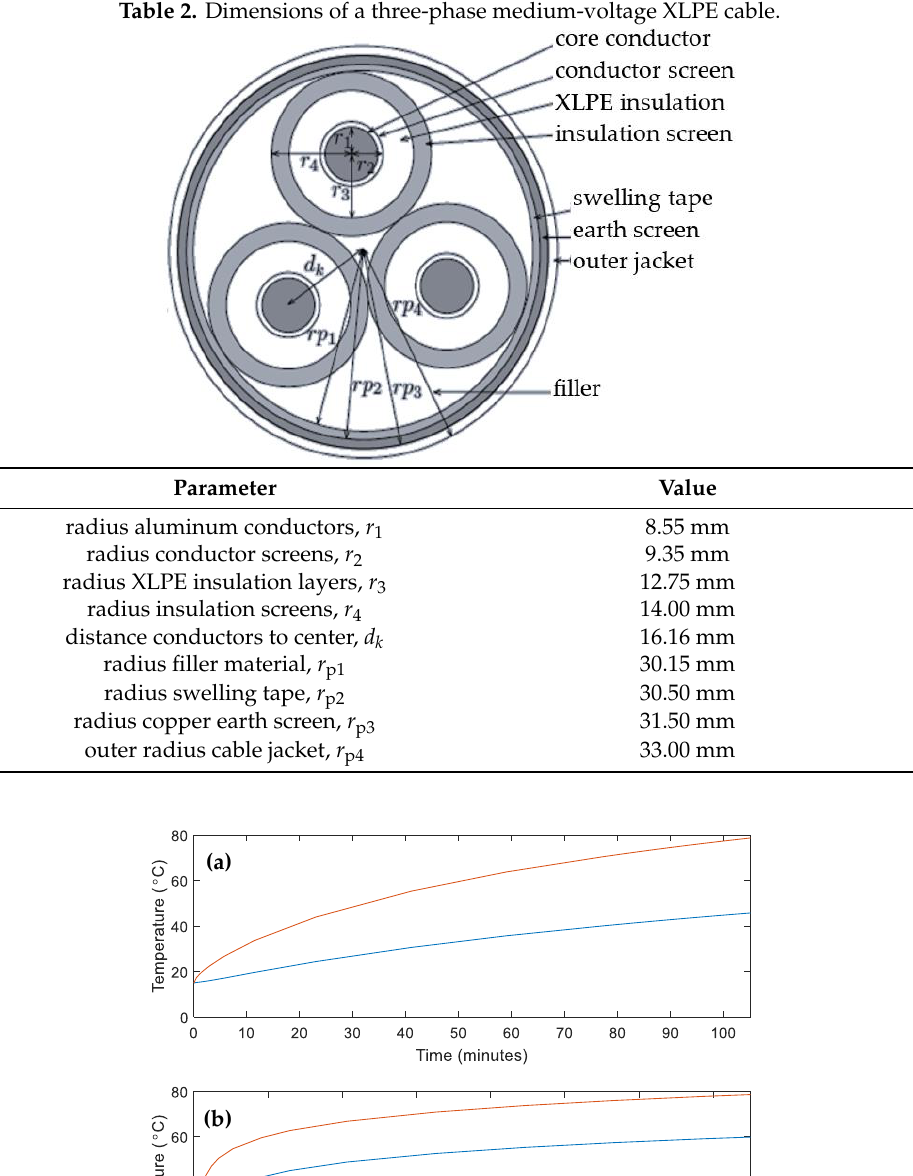
Figure 3. Scheme for modeling the time-domain response during cable loading. Table 2. Dimensions of a three-phase medium-voltage XLPE cable. Table 2. Dimensions of a three-phase medium-voltage XLPE cable.